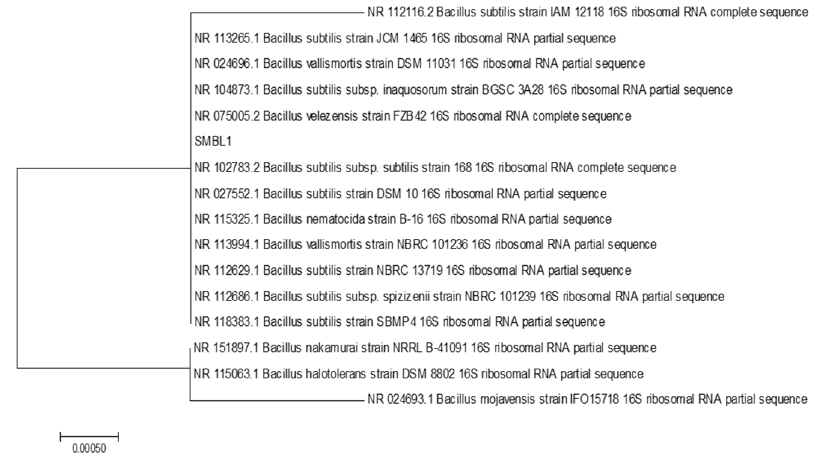
Figure 1. Phylogenetic tree of the bacterial strain Bacillus subtilis (SMBL 1) (accession #MN007187).